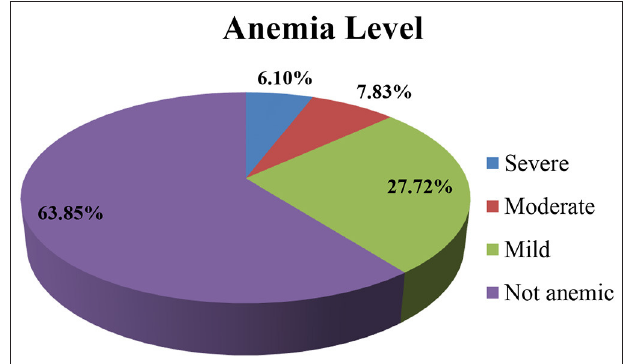
FIGURE 1 | Magnitudes of anemia among lactating mothers in East African countries,